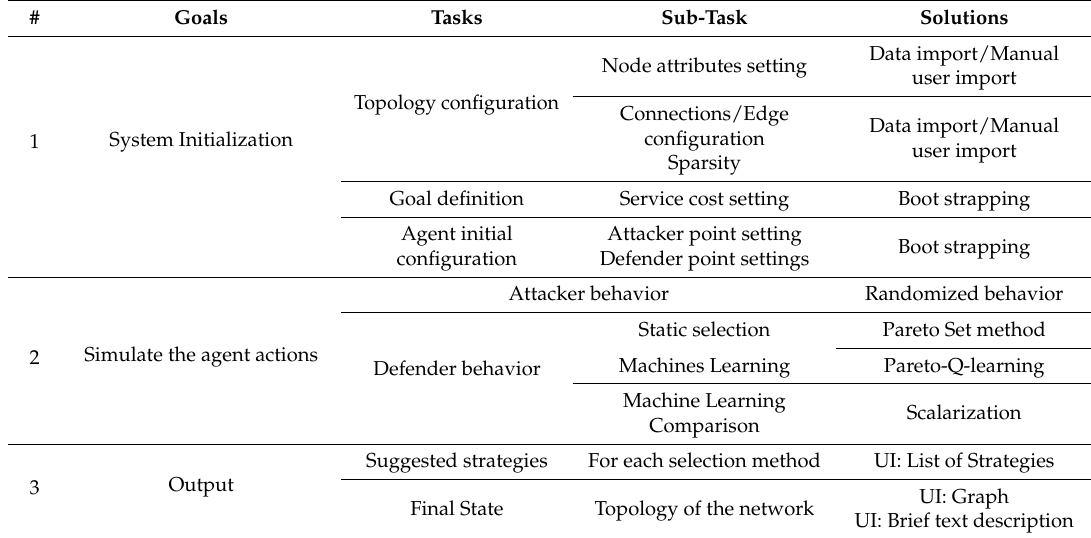
Figure 9. Distribution of algorithm running times. Table 4. System tasks and